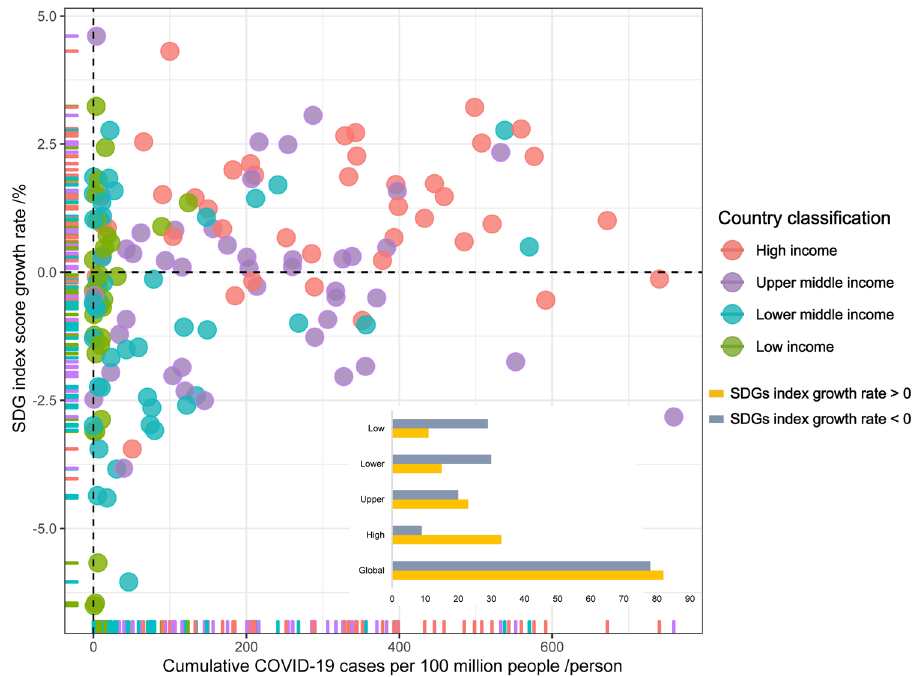
Fig. 2 The relationship between the con fi rmed COVID-19 infection rate (cumulative cases per 100 million people in 2020) and SDG index score growth rate (2020 compared to 2019) globally. The bar chart shows the number of countries (divided into global, high-income, upper-middle-income, lower-middle-income, and low-income countries) achieving positive and negative SDG growth (2020 compared to 2019), respectively. We collected data from the Sustainable Development Report 2020 (https://www.sdgindex.org/reports/sustainable-development-report-2020/) and the WHO Coronavirus (COVID-19) Dashboard